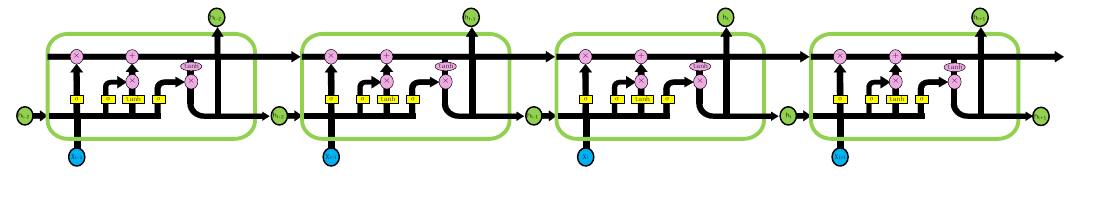
Figure 6. Cascade structure of LSTM.